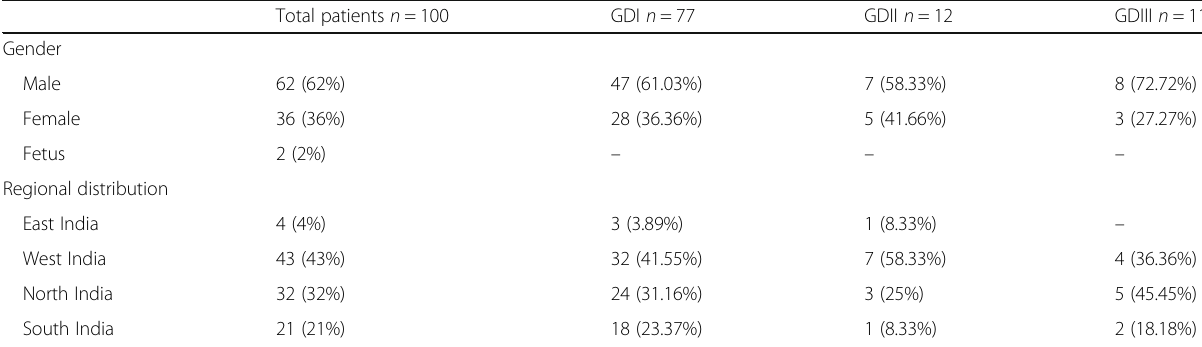
Table 1 Demographic profile of the patients with Gaucher disease Total patients n =